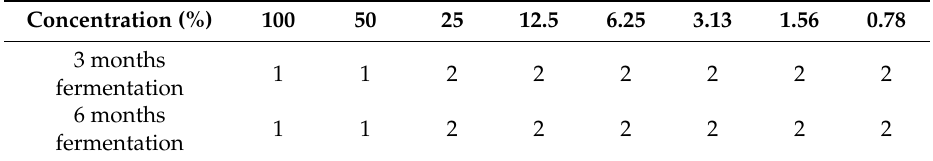
Table 1. Enterococcus faecalis growth at different concentrations of pineapple-orange eco-enzymes (M-EE).